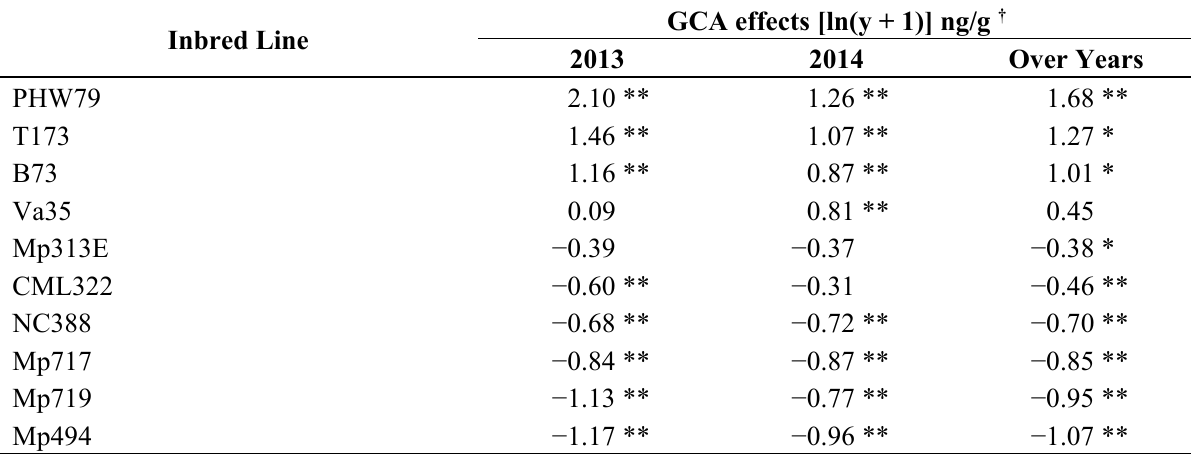
Table 4. Estimates of general combining ability (GCA) effects for 10 inbred parental lines of a diallel cross of maize grown at Mississippi State in 2013 and